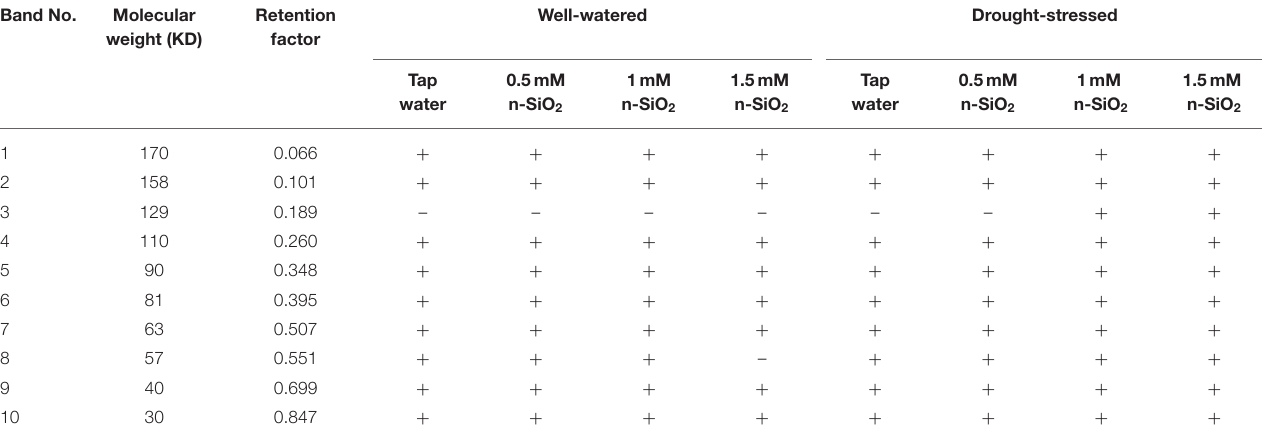
TABLE 5 | Effect of nano-silicon dioxide (nano-SiO 2 ) on protein profile in faba bean ( Vicia faba ) seeds under well-watered and drought-stressed conditions. Band